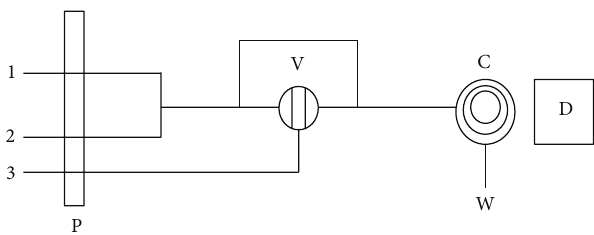
Figure 1: Schematic of flow injection chemiluminescence analysis. 1: Mixture of NaOH and luminol, 2: K 3 Fe(CN) 6 solution, 3: ENRO solution,P:peristalticpump,C:flowcell,V:injectionvalve,W:waste solution, and D: detector.